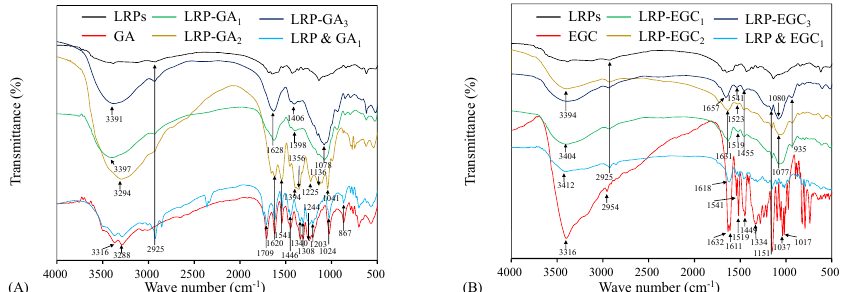
Figure 4. FTIR spectra of LRPs, polyphenols, LRP-phenol complexes, and their physical mixtures. LRPs, GA, LRP-GA complexes, and their physical mixture ( A ); LRPs, EGC, LRP-EGC complexes, and their physical mixture ( B